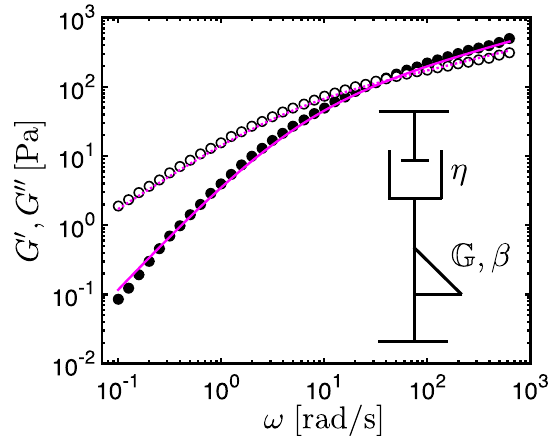
FIG. 5. Fitting of the elastic and loss modulus measured with a classical frequency sweep ( G 0 , filled circle; G 00 , circle). This is the same data as in Fig. 1, determined with 30 points per decade but plotted with only ten points per decade for clarity. The super- posed magenta lines ( G 0 , line; G 00 , dashed line) are best fits of the analytical expressions for the moduli based on the fractional Maxwell model presented in Sec. III A, which give α ¼ 1 , V ¼ η ¼ 18 Pa s, β ¼ 0 . 36 , and G ¼ 50 Pa s 0 . 36 . The inset shows the mechanical analog for the FMM, where one of the elements becomes effectively a classical viscous dashpot since α ¼ 1